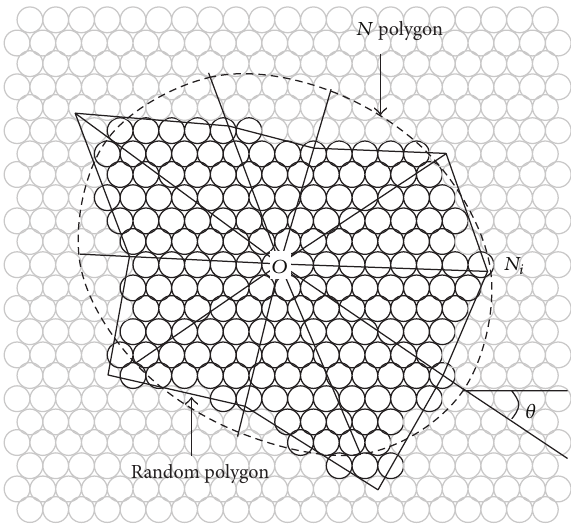
Figure 2: An arbitrarily shaped stone block depicted by a particles